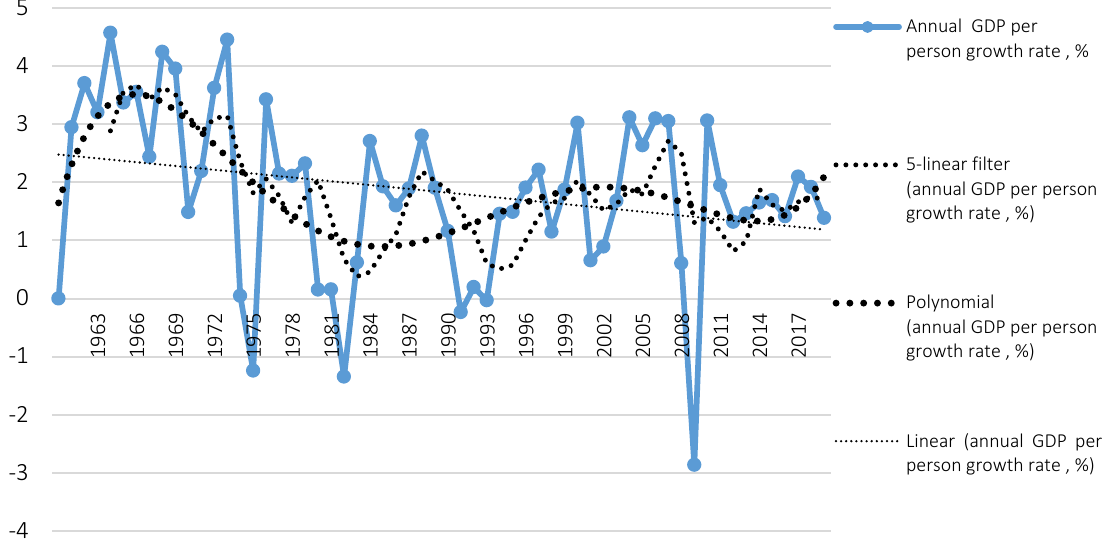
Figure 2. Cyclical dynamics of global GDP per